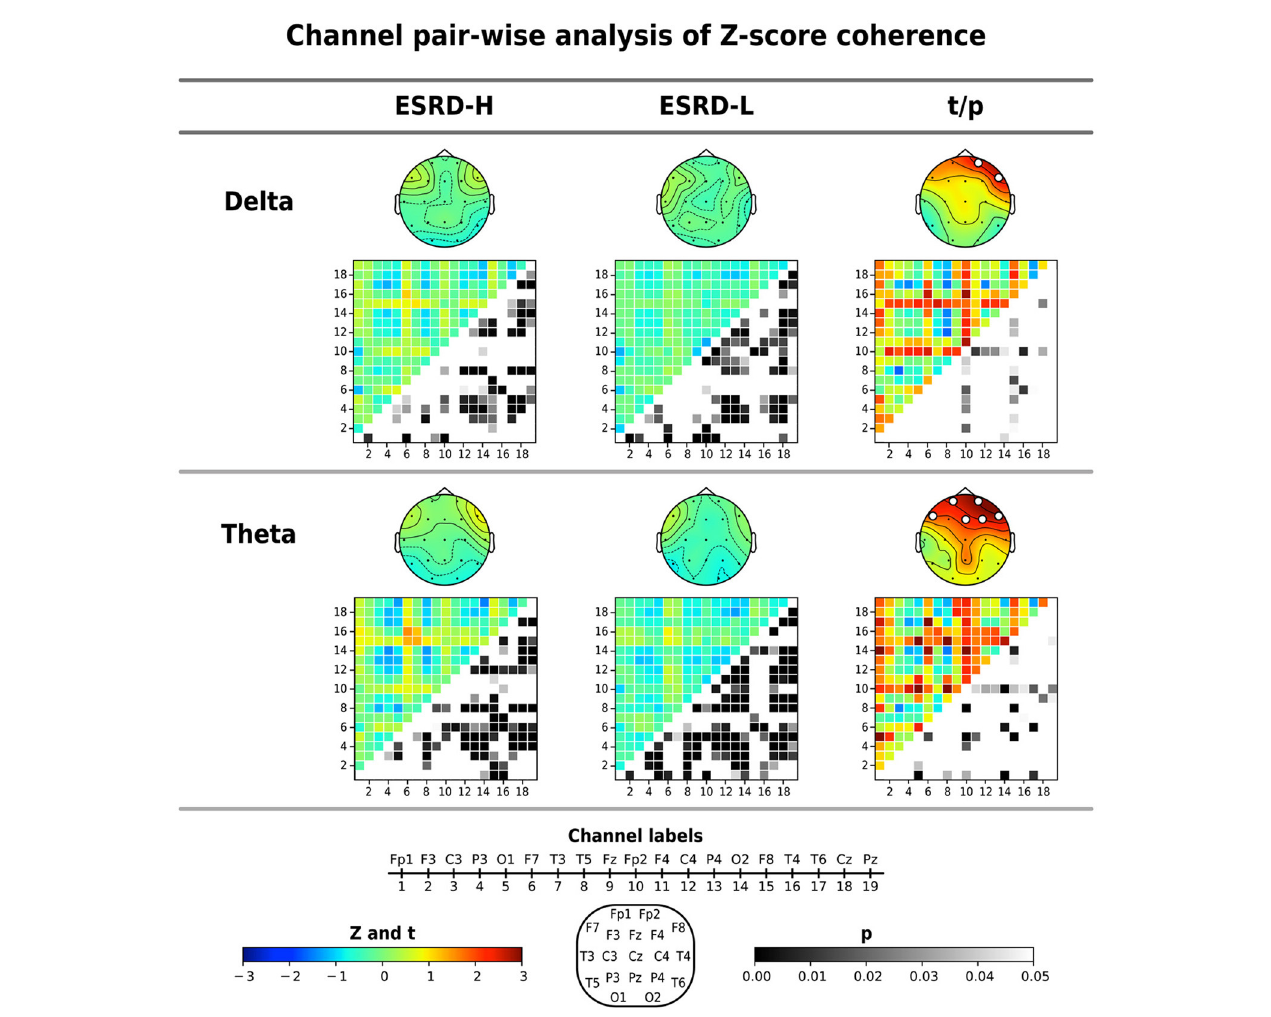
FIGURE3 The significant findings from the global average Z-score coherence comparison were identified for each channel pair by using permutation-based t -tests. The average Z-score and significant channel t -values are shown in the topographical maps. Coherence matrices (19 x 19 channels), in which the upper triangular part indicates the Z - or t -values (171 values) and the lower triangular part signifies their corresponding p -values (171 values), are also shown. Note that the p -values of the upper triangular Z-scores were obtained through comparisons to zero using one-sample permutation tests. All values are represented by color bars, and the electrode channels are represented by